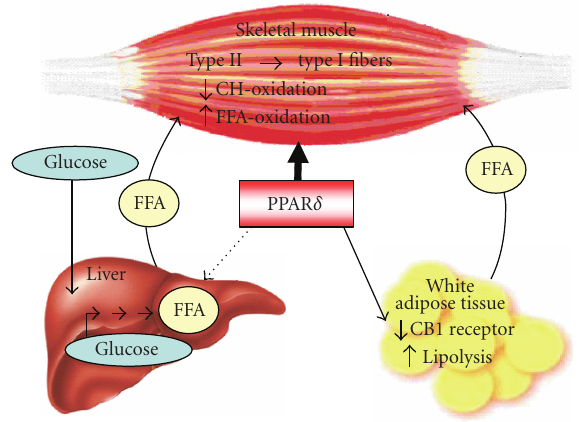
Figure 1: Central, fuel-switching mechanisms by which PPAR δ increases the use of fatty acids in skeletal muscle without provoking insulin resistance. Dotted arrow: indirect e ff ect. For abbreviations, the reader is referred to the